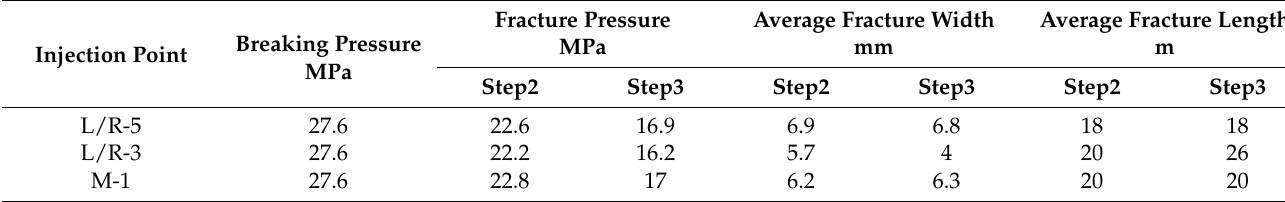
Figure 9. The minimum principal stress nephogram of initial fracturing. The curve represents the minimum stress at the red horizontal point in the middle of the model. Table 2. Statistical table of initial fracturing data.